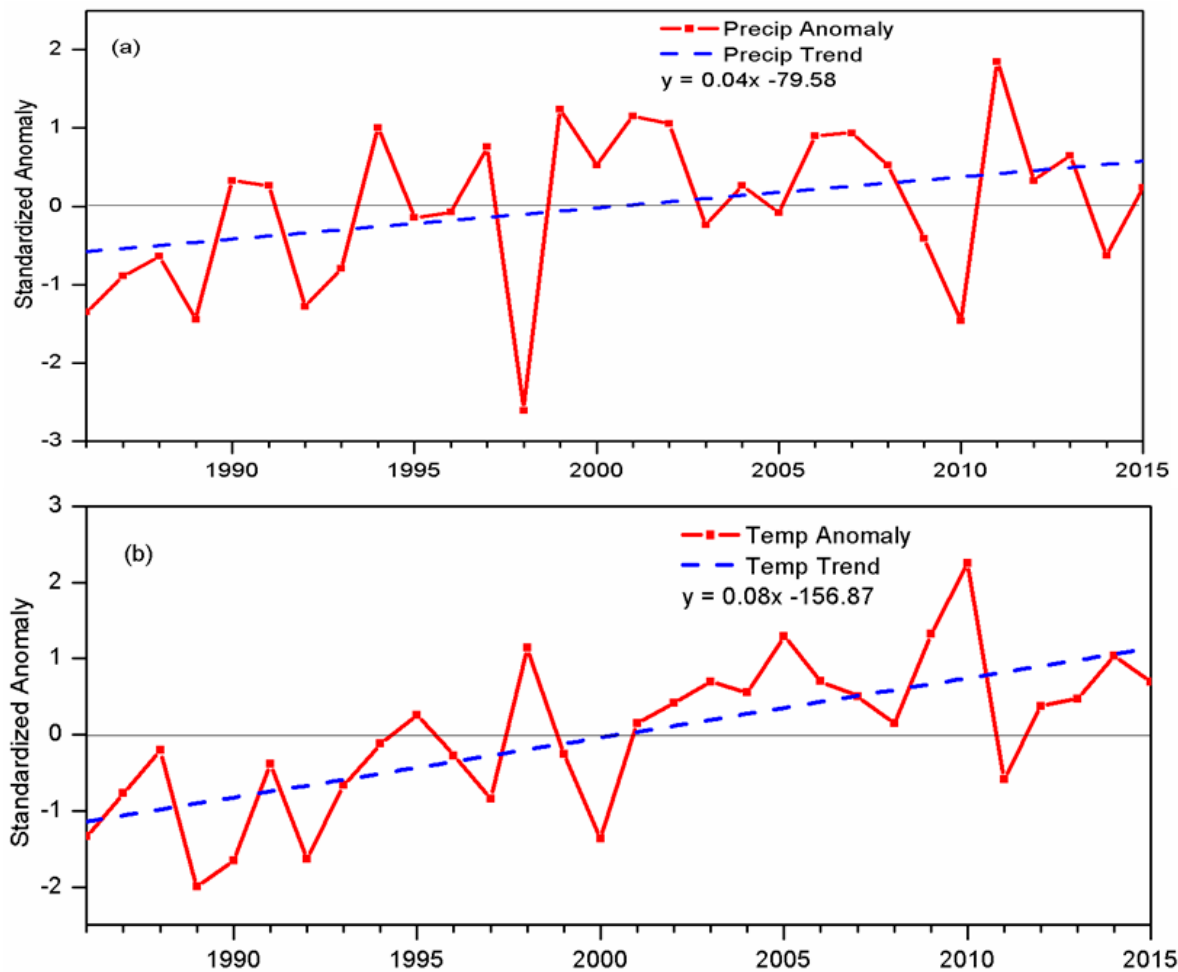
Figure 4. Linear trend of annual ( a ) rainfall (mm); and ( b ) temperature (°C) anomaly over Myanmar from 1986 to2015. The red lines are the annual anomalies and the blue lines are the linear trends.